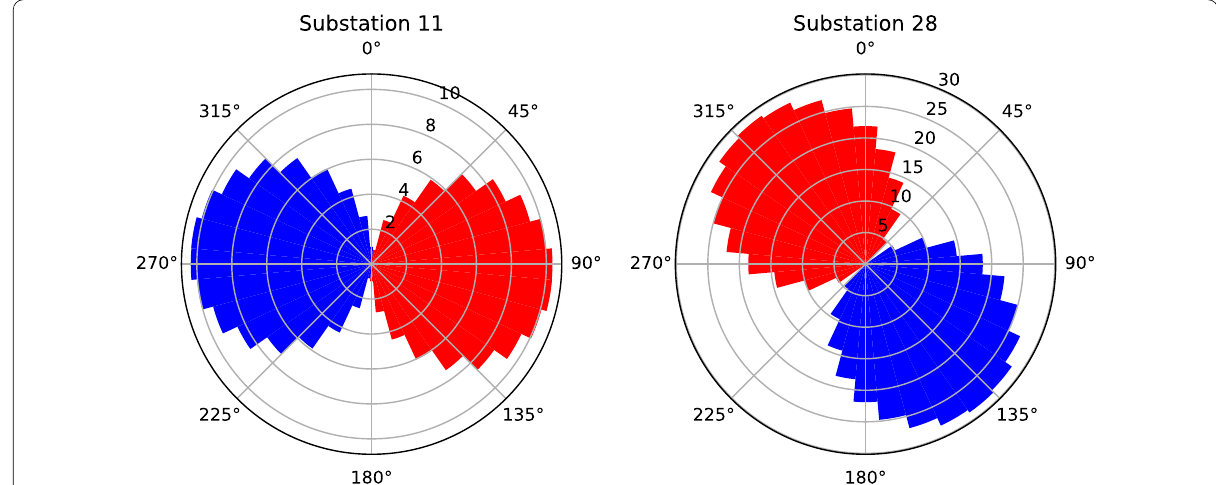
Fig. 9 Two examples of the directional analysis for the 1-V/km uniform geoelectric field. The amplitudes of the GIC at the given substation are plotted in the polar plot. The red and blue colours indicate positive and negative GIC values, respectively. The azimuth of 0 indicates the northbound field, value of 90 indicates the eastbound